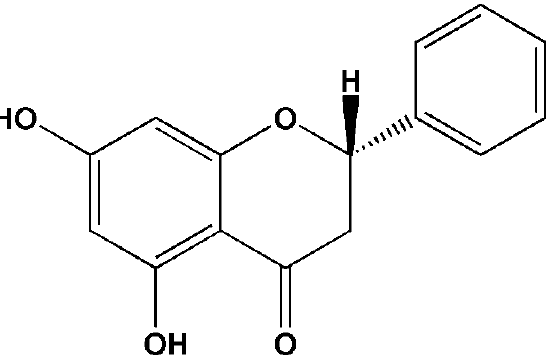
Figure 1. Chemical structure of (2S)-pinocembrin. Overall, this article reviews and expounds in detail the progress on pinocembrin biosynthesis, its pharmacological actions and partial mechanisms, and certain drug metabolism characteristics in vitro and in vivo, which will provide advantageous information for the comprehensive study of the pharmacokinetic (PK) features and pharmacological mechanisms of pinocembrin.